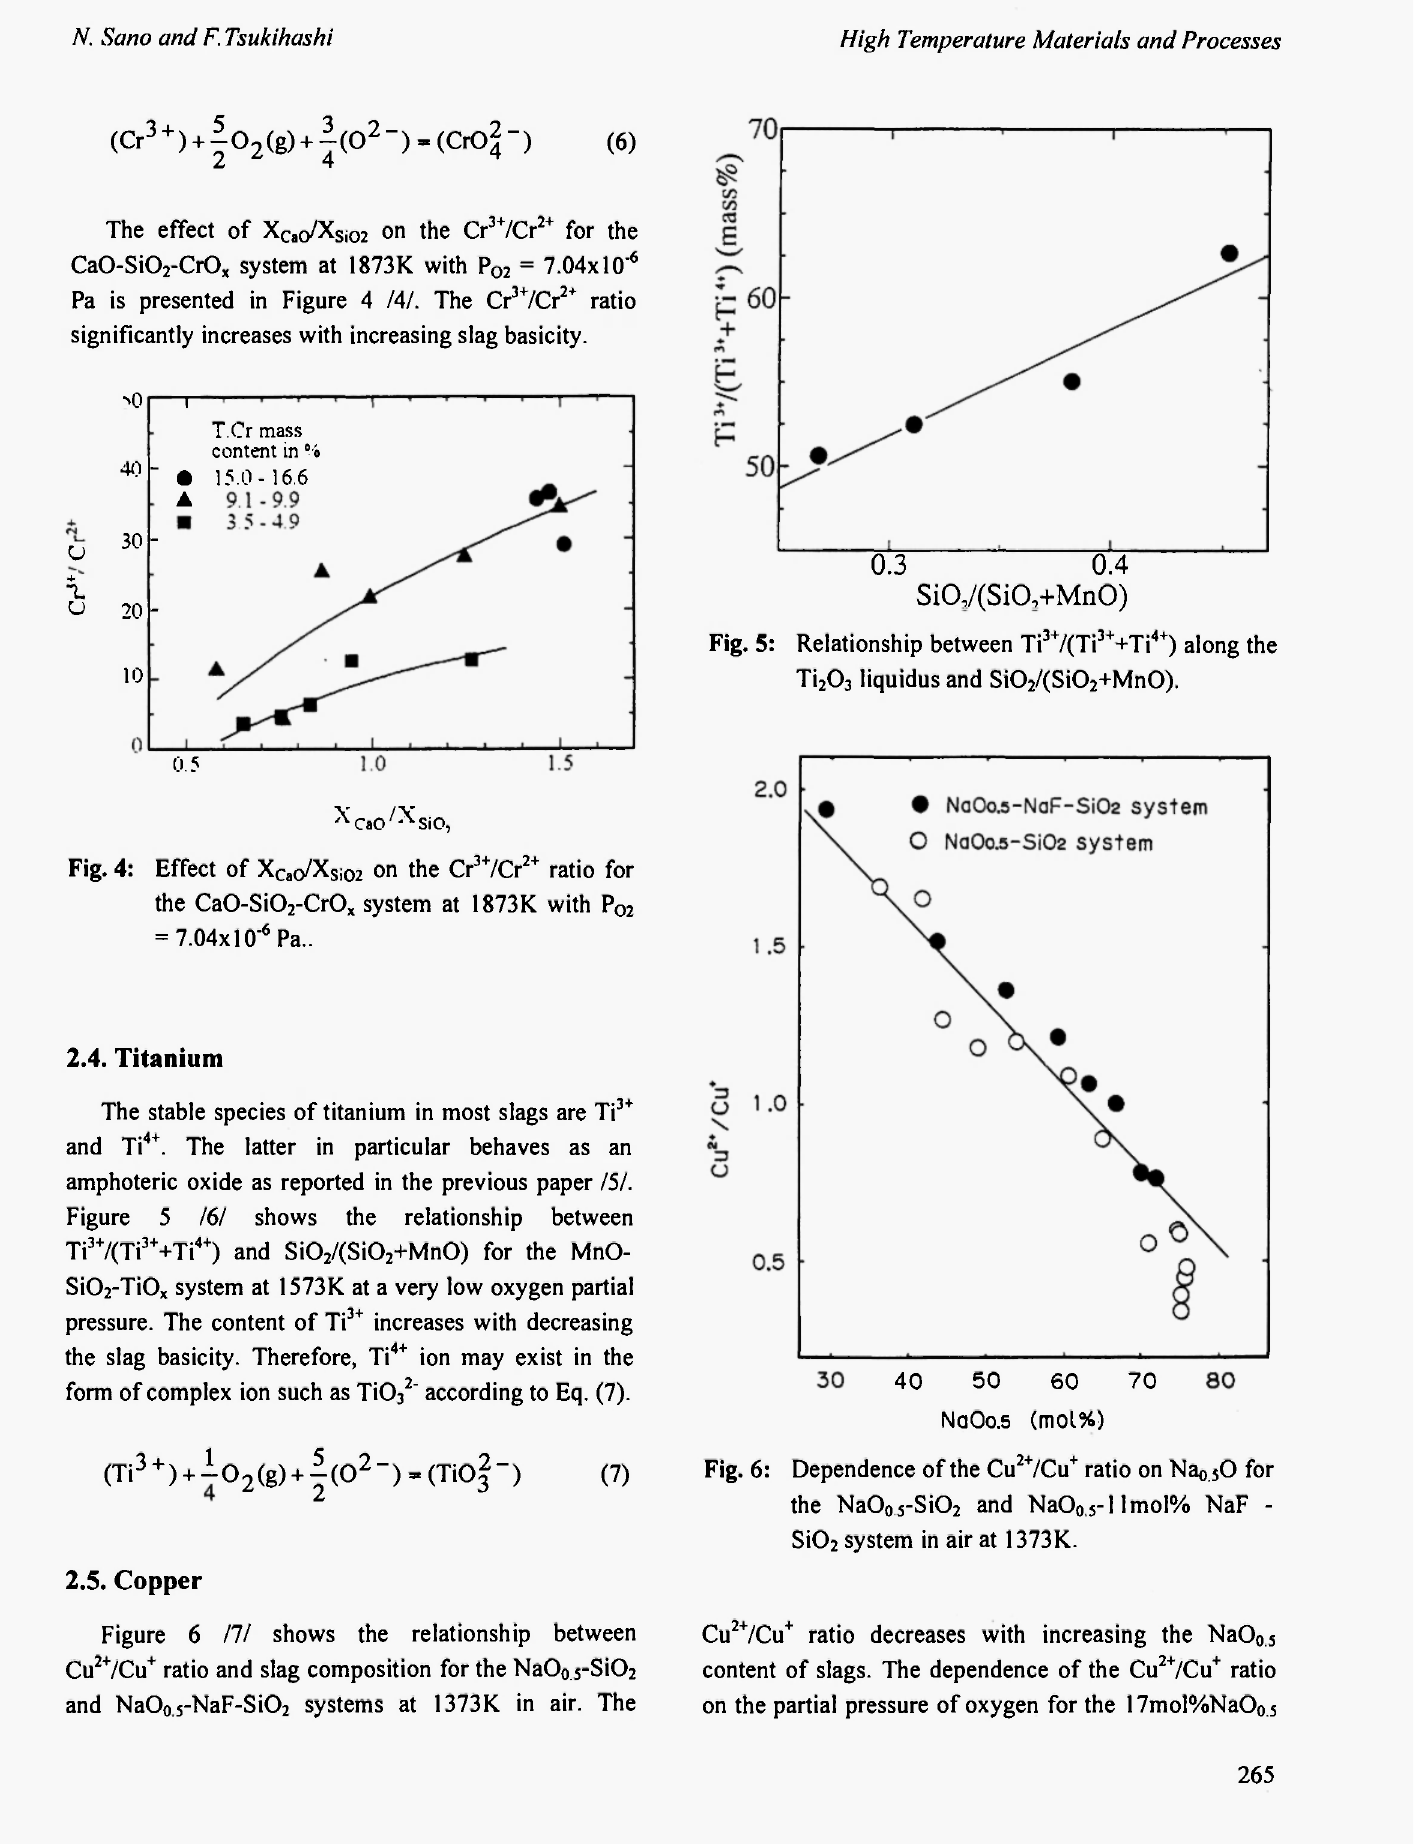
Figure 6 111 shows the relationship between Cu 2+ /Cu + ratio and slag composition for the NaO 0 5 -Si0 2 and NaO 0 5-NaF-Si0 2 systems at 1373K in air. The